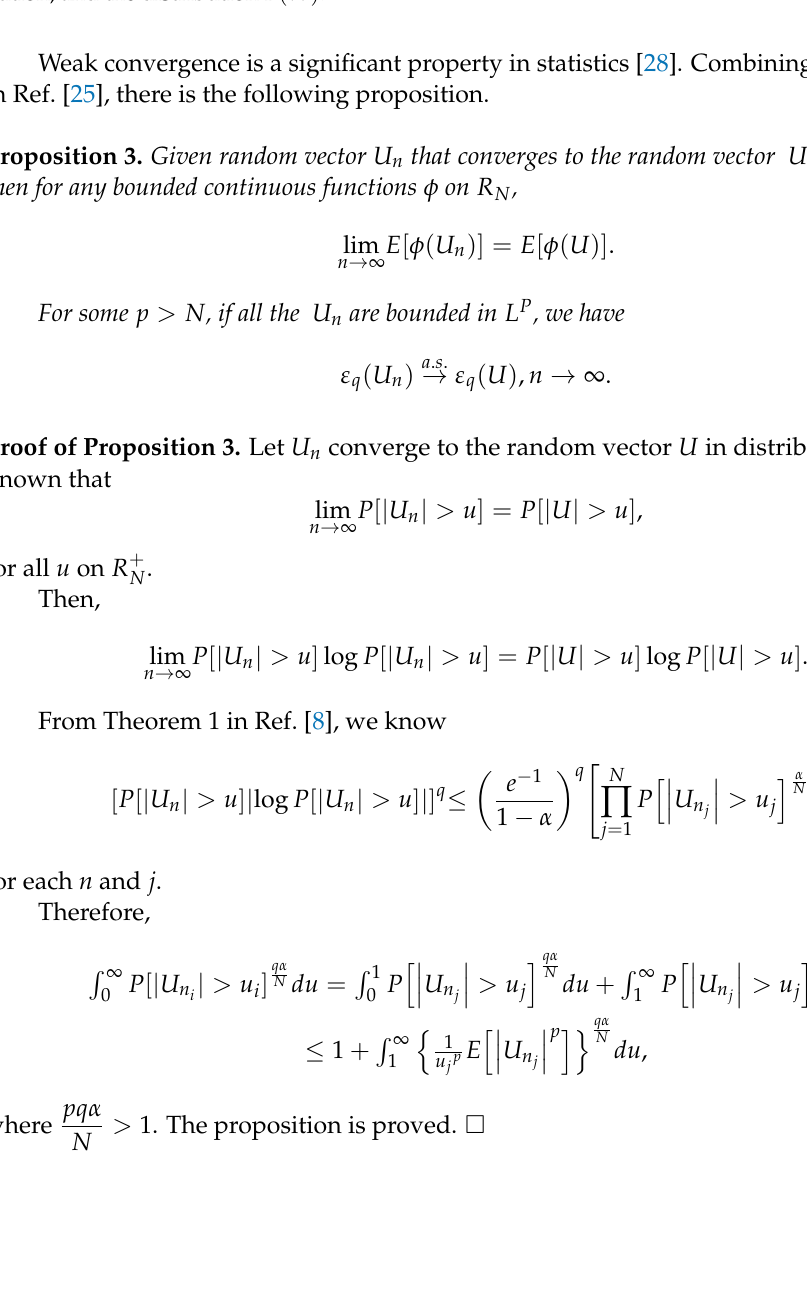
Figure 3. The fractional cumulative residual entropy of the uniform distribution, exponential distri- bution, and the distribution F ( W ) .